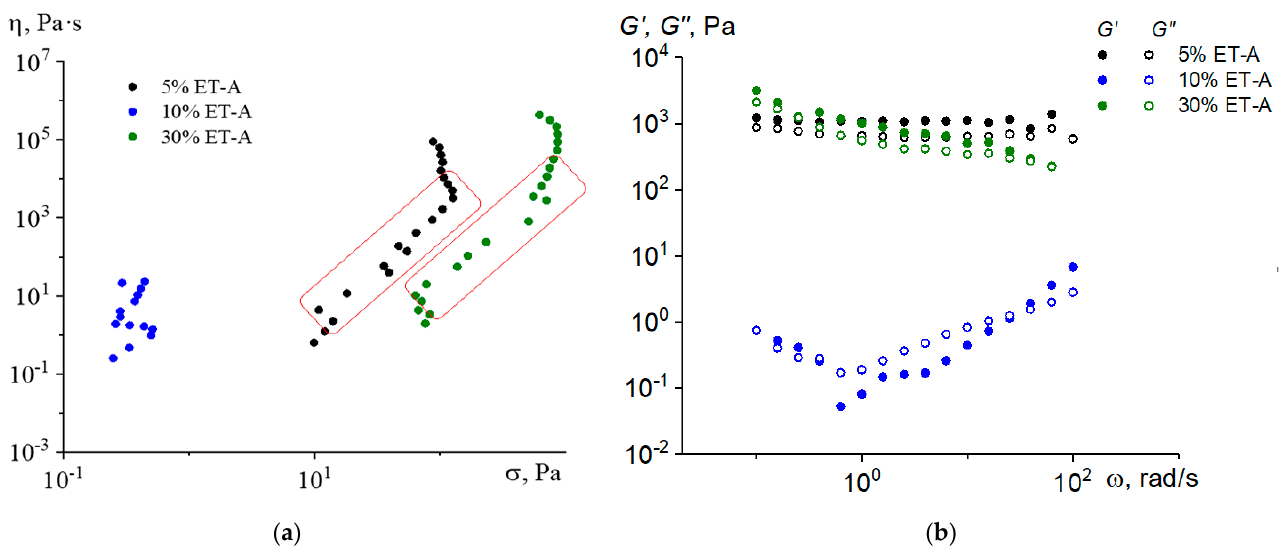
Figure 2. Dependence of viscosity on shear stress ( a ) and frequency dependences of storage and loss moduli ( b ) of paraffin composites containing ET ‐ A asphaltenes, T = 80 °C. Marked areas in Fig 2a with reverse slope correspond to deterioration of the structural network of composites.